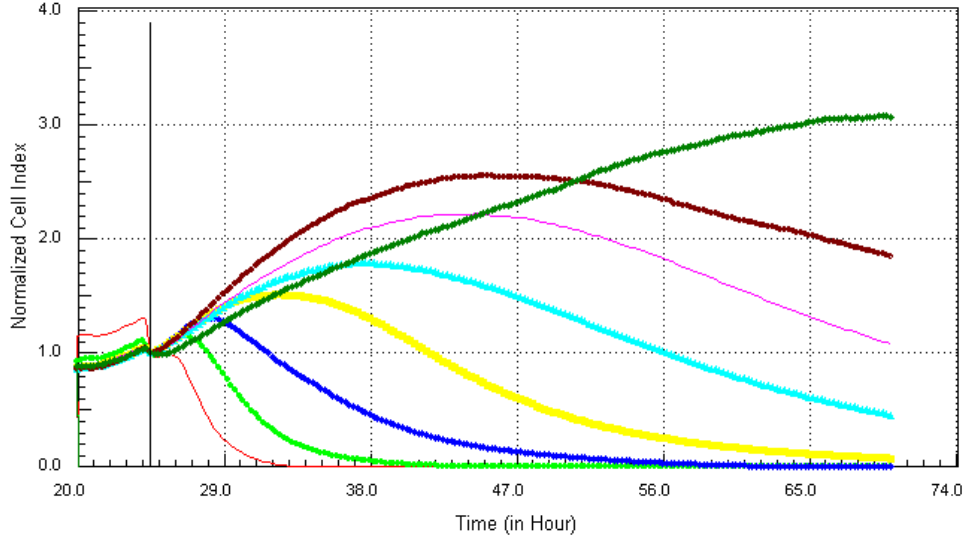
Figure 2. Kinetics of cytotoxic responses for arsenic (As) in MCF7 cells as described in Figure 1 legend.